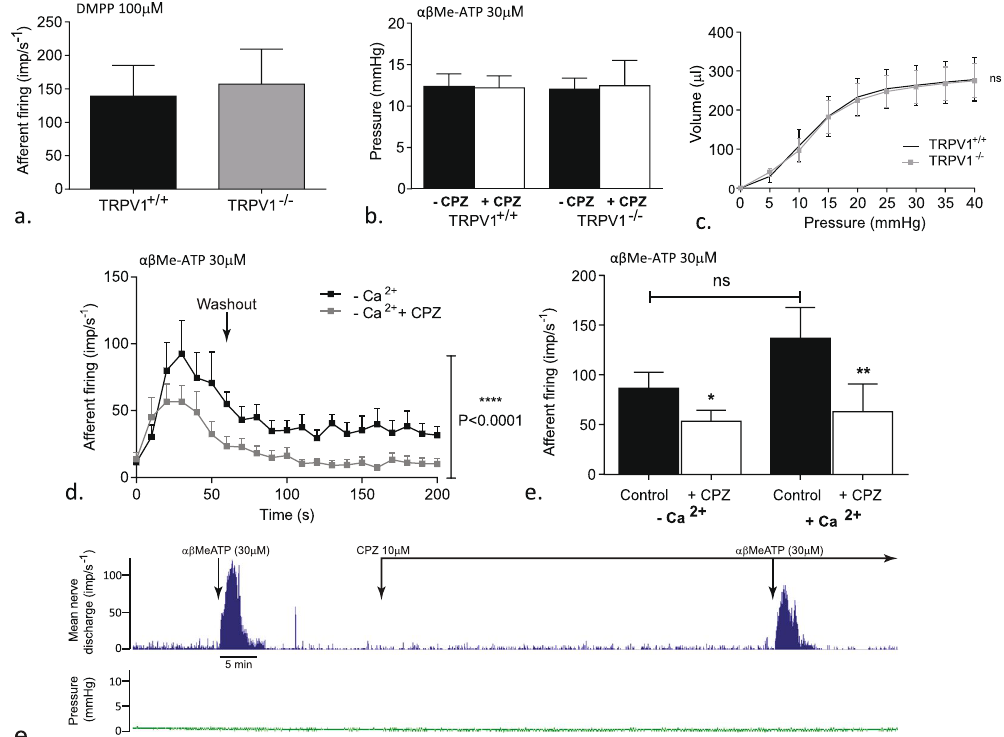
Figure 3. TRPV1 is coupled to P2X mediated afferent firing. ( a ) Peak afferent nerve responses to bath applied DMPP (100 µ M) in TRPV1 + / + and TRPV1 − / − mice. ( b ) Bladder contraction responses to αβ Me-ATP (30 µ M) in the presence (white bars) and absence (black bars) of capsazepine in TRPV1 + / + and TRPV1 − / − mice. ( c ) pressure/volume relationship within the bladder when distended with saline in TRPV1 + / + and TRPV1 − / − mice. ( d ) Afferent nerve response to repeated applications of αβ Me-ATP for 60 s in calcium free modified krebs solution with, or without, capsazepine (10 µ M); Data shown are mean ± SEM, two-way ANOVA with Bonferroni post-test **** p ≤ 0.0001 (n = 7). ( e ) Afferent response to αβ Me-ATP (30 µ M) in calcium free modified Krebs solution with or without capsazepine. Data shown are mean ± SEM, one-way ANOVA